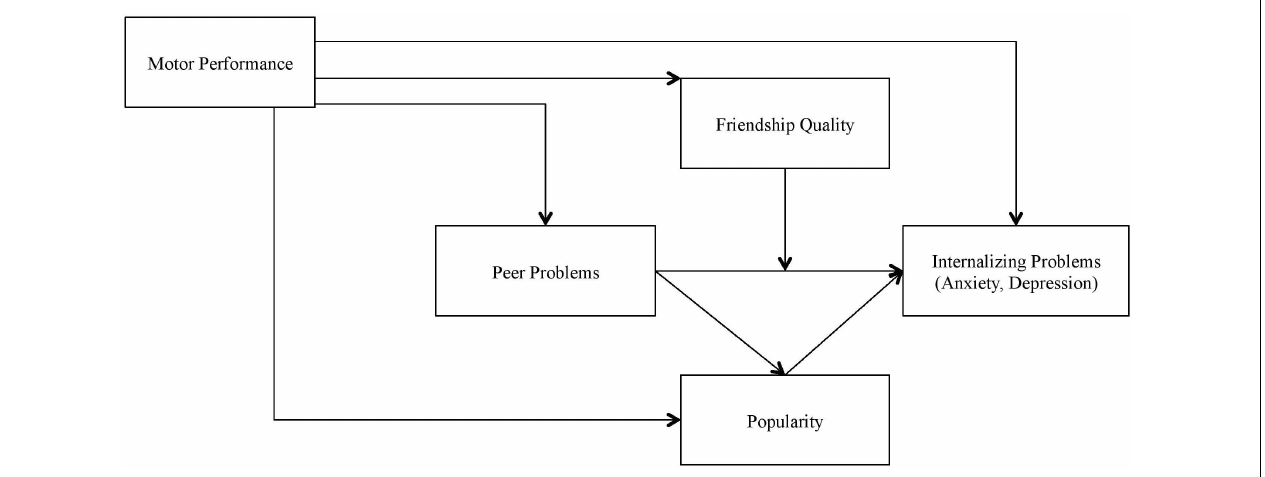
FIGURE 2 | The working model within the framework of the Environmental Stress Hypothesis with the paths tested in the